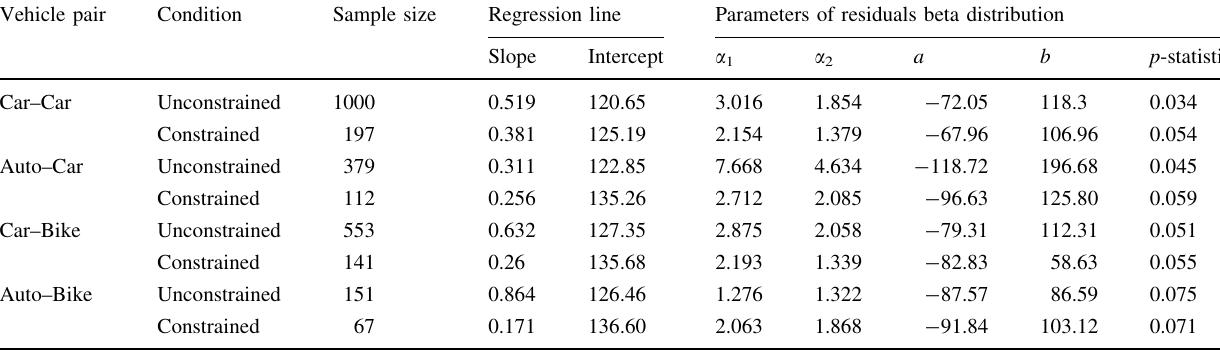
Table 5 LC versus average speed model for different pairs in constrained and unconstrained conditions Vehicle pair Condition Sample size